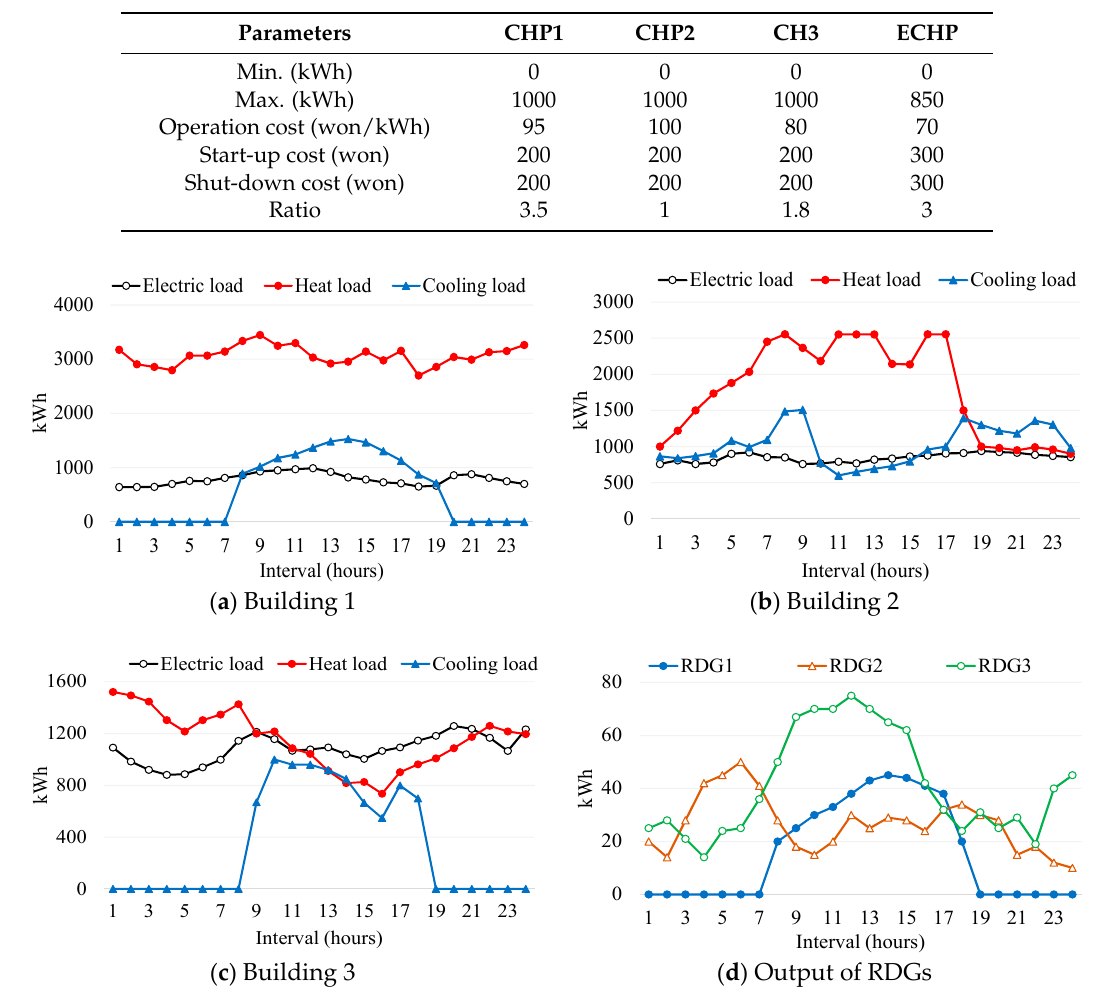
Figure 5. Load profiles and output power of RDG in each building during a weekday.